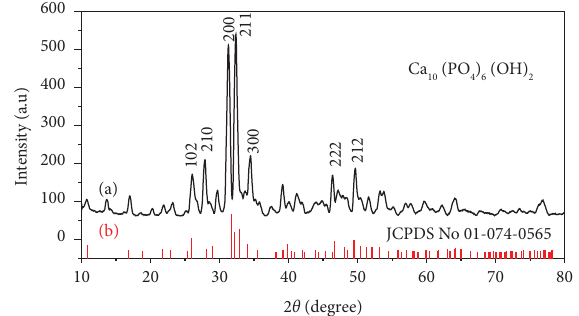
Figure 3: (a) XRD pattern of synthesized HAp NPs and (b) standard difraction